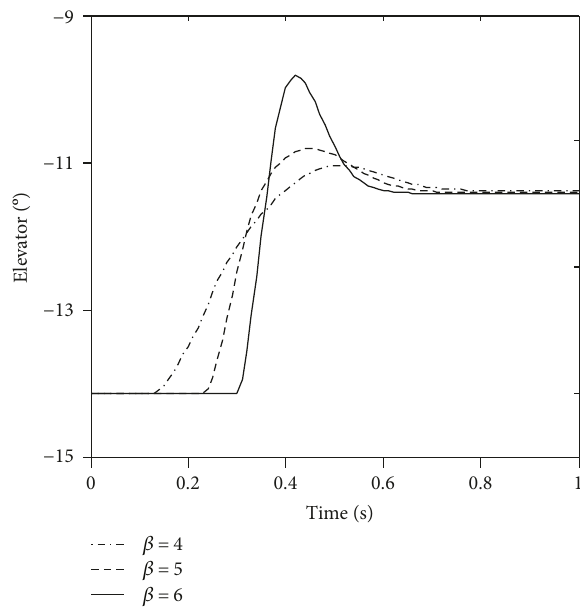
Figure 2: Time history of elevator de fl